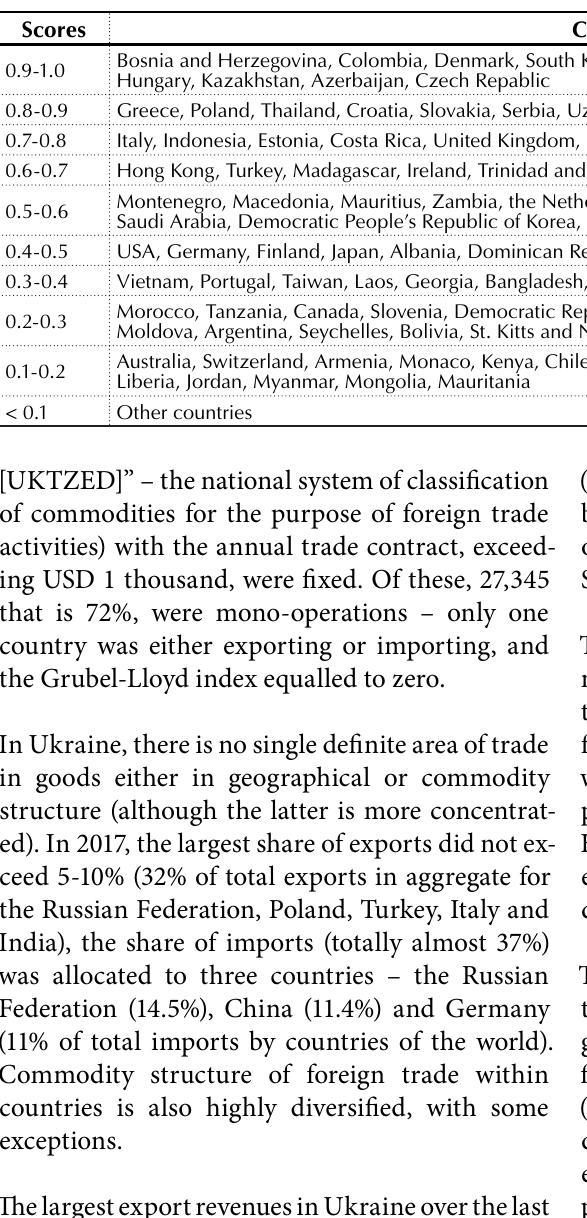
Table 2. Country groupings by the Grubel-Lloyd index (geographical